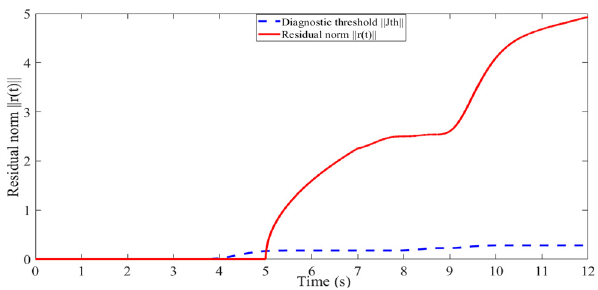
Figure 9 Fault detection results of the rotation angle sensor